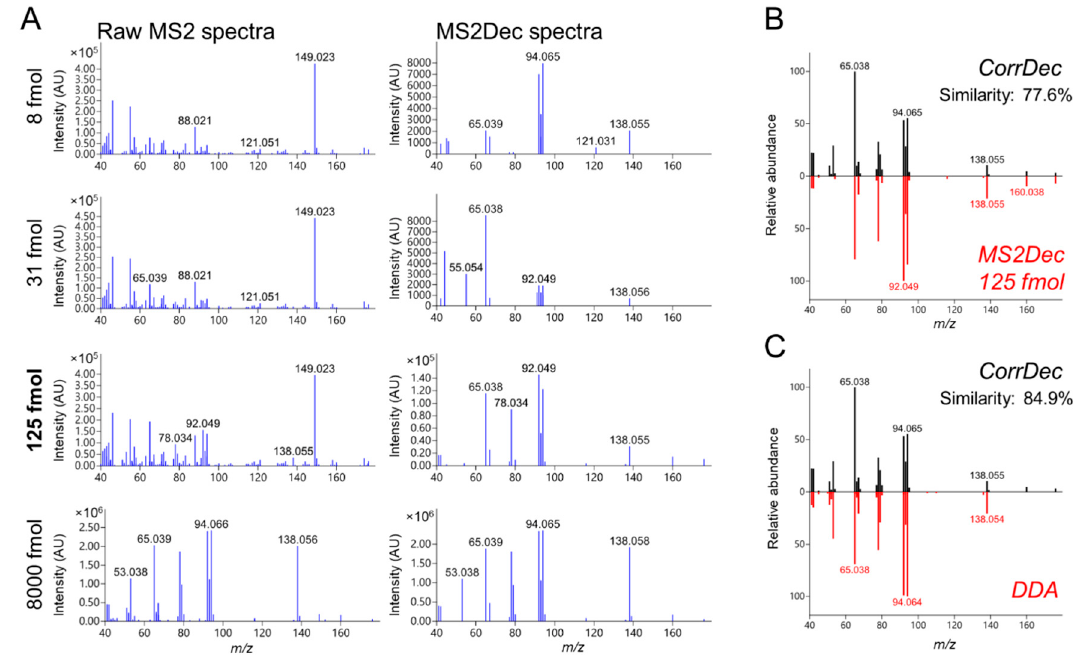
Figure 3. Deconvolution of trigonelline (C 7 H 7 NO 2 , monoisotopic mass 137.0477) MS2 spectra from AIF data at 30 eV. ( A ) Raw trigonelline AIF spectra contain multiple noise peaks (left column), compared with MS2 spectra deconvoluted by MS2Dec (right column), especially when lower amounts were injected. ( B ) MS2Dec and CorrDec yield similar MS2 spectra. ( C ) Comparison between CorrDec and DDA MS2 spectra acquired in house at 30 eV (MoNa ID: MoNA011431) confirms the solid MS2 deconvolution from the AIF data. Similarity reported as the dot product.